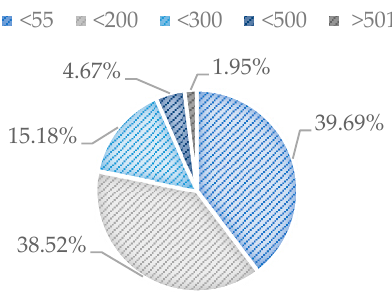
Figure 4. Users’ consumptions distributions in tariff bands.